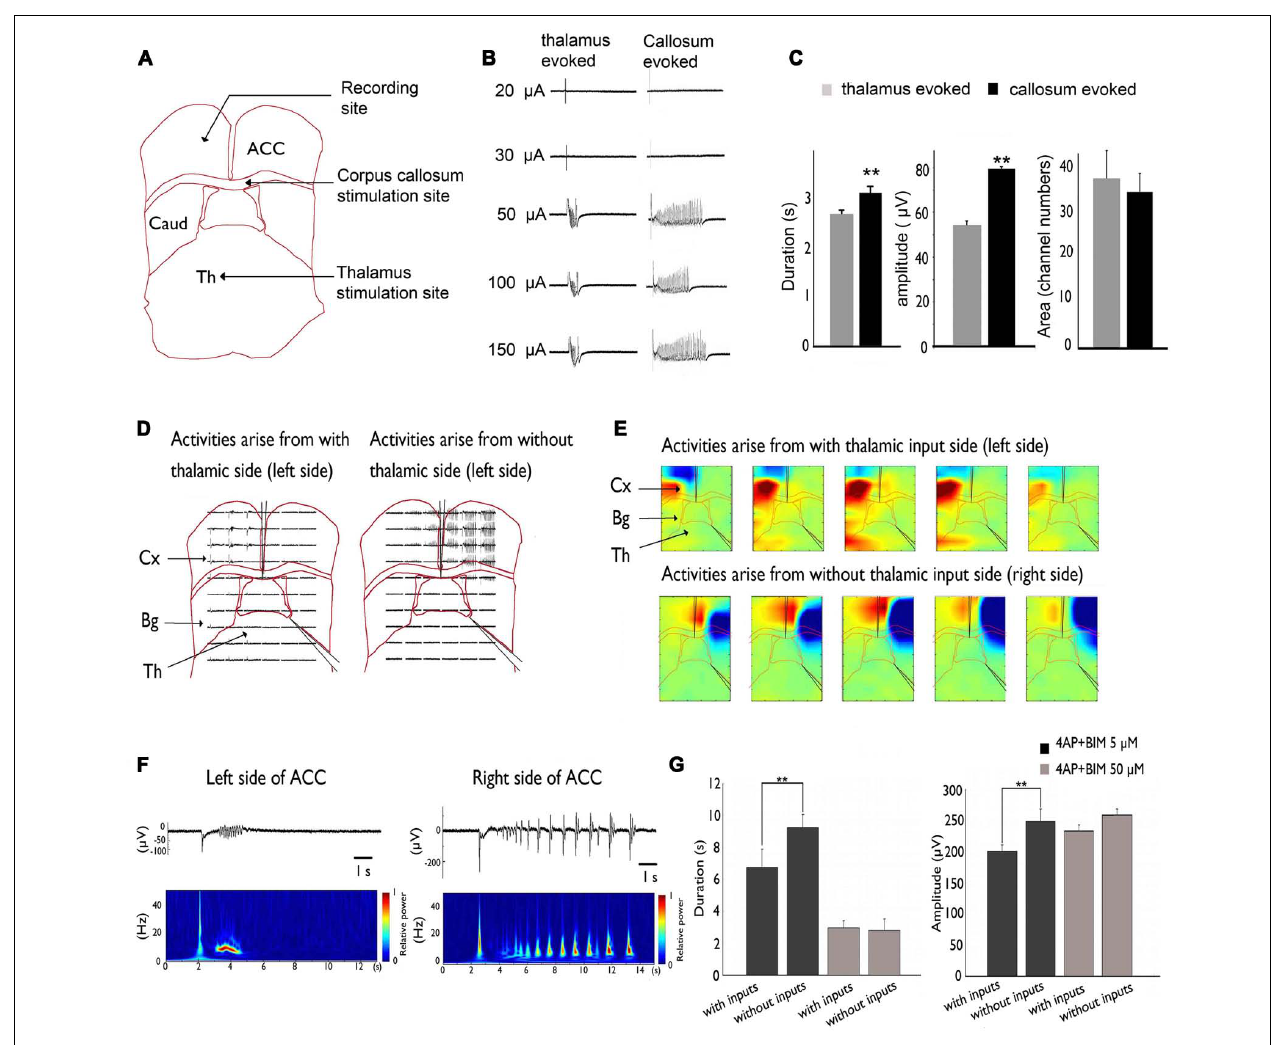
FIGURE 2 | Inhibitory effect of MT stimulation on 4AP + bicuculline- induced epileptiform activity. (A) Stimulation sites in the MT and CC and recording site in the ACC. (B) Activity evoked by MT and CC stimulation. Evoked responses were all-or-none because they were not altered by changes in stimulation intensity. (C) The duration and amplitude of epileptiform activity were significantly greater in response to CC stimulation than in response to MT stimulation. (D) A cut was made in the middle of the corpus callosum and at the border between the thalamus and basal ganglia. Epileptiform activity that arose from the side without thalamic inputs was significantly larger than the activity that arose from the side with thalamic inputs. (E) Pseudocolor